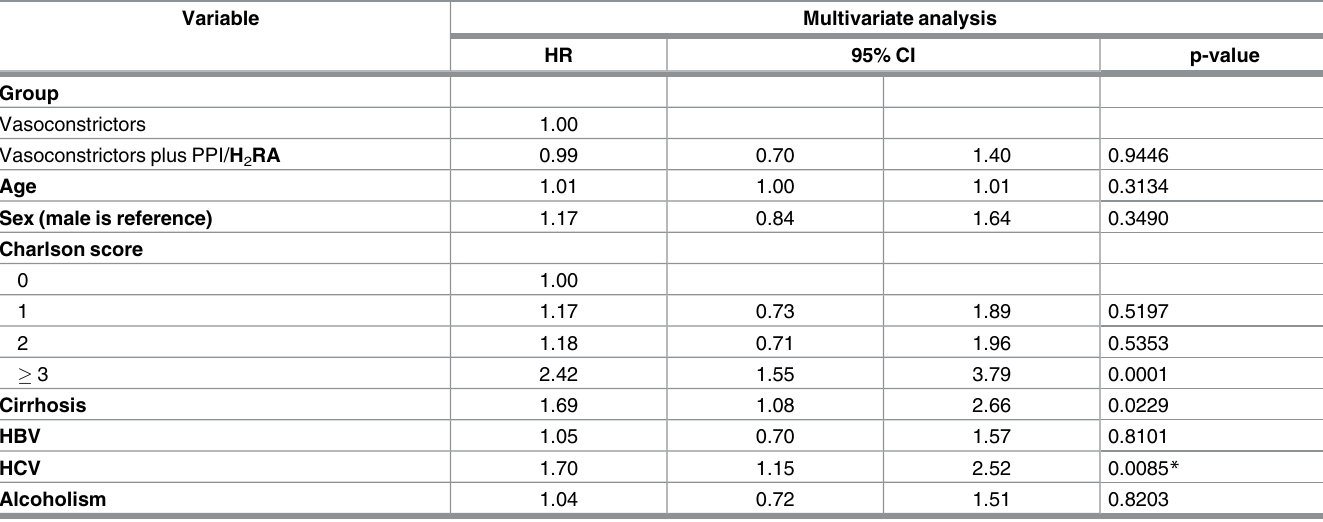
Table 5. Independent risk factors of death in all study populations during 15-yearfollow-up